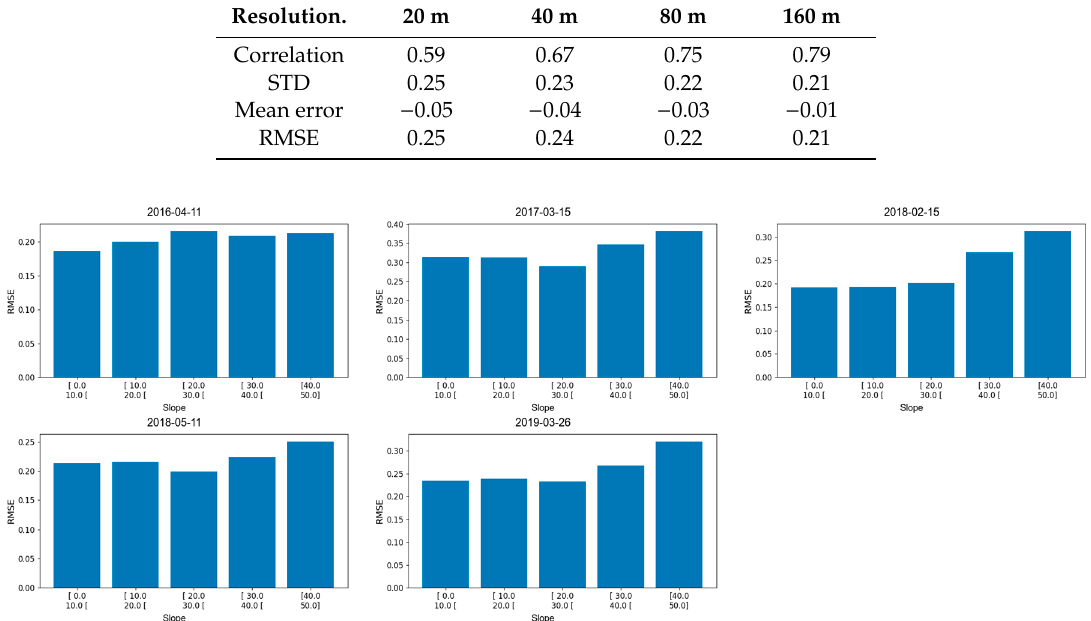
Figure 12. RMSE of the FSC by class of slopes for each image from the Pléiades validation dataset (Sect. 3.1).